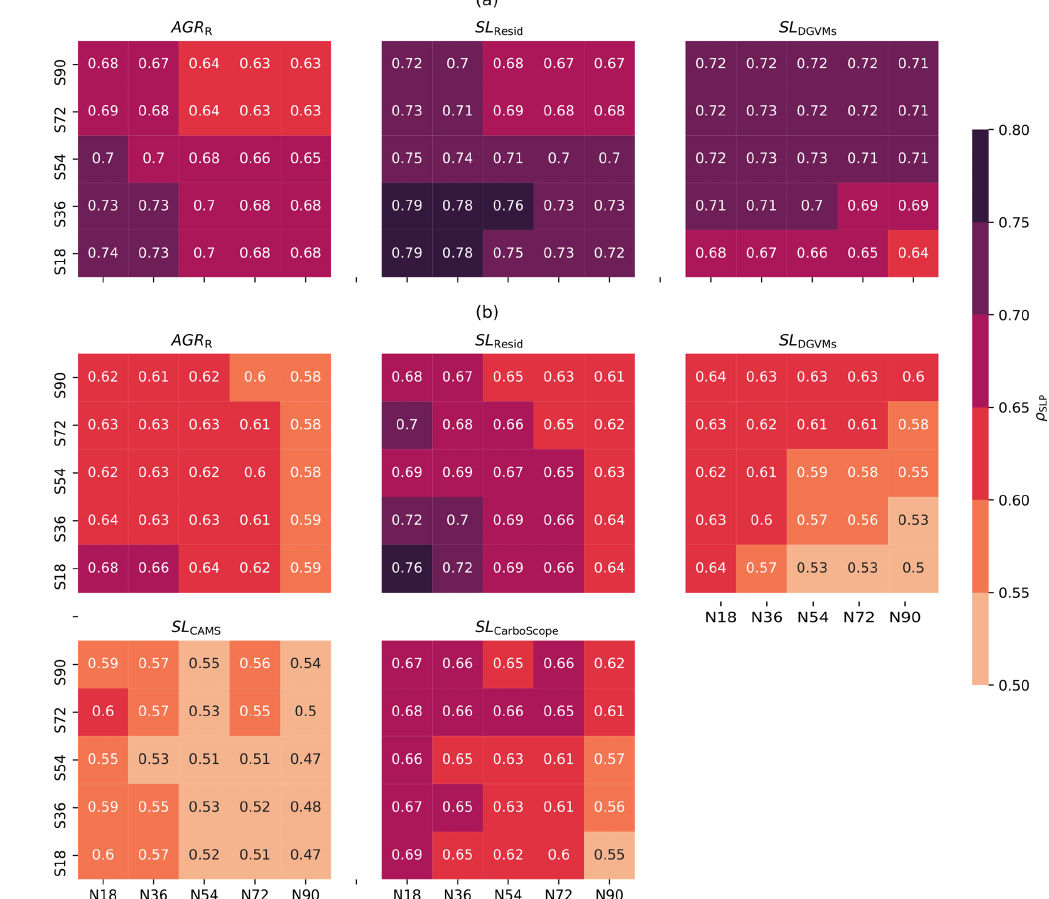
Earth Syst. Dynam., 13, 1505–1533,